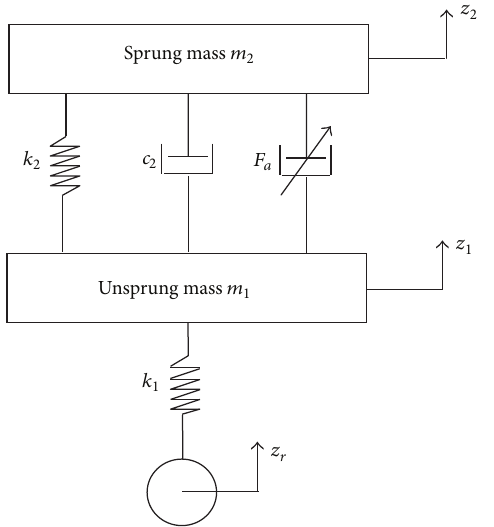
Figure 2: The quarter car suspension model.